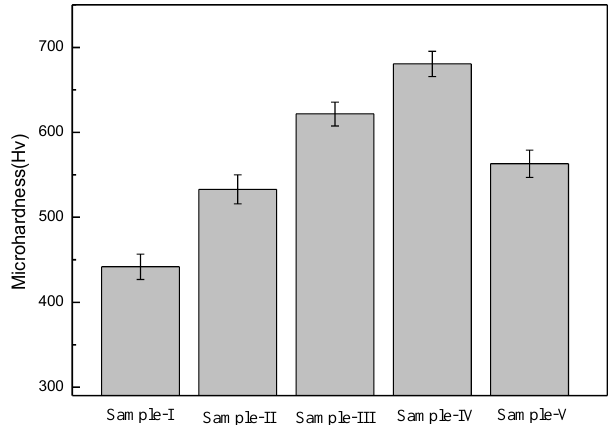
Figure 7. Microhardness curves of alloy coated samples deposited under different external fields.